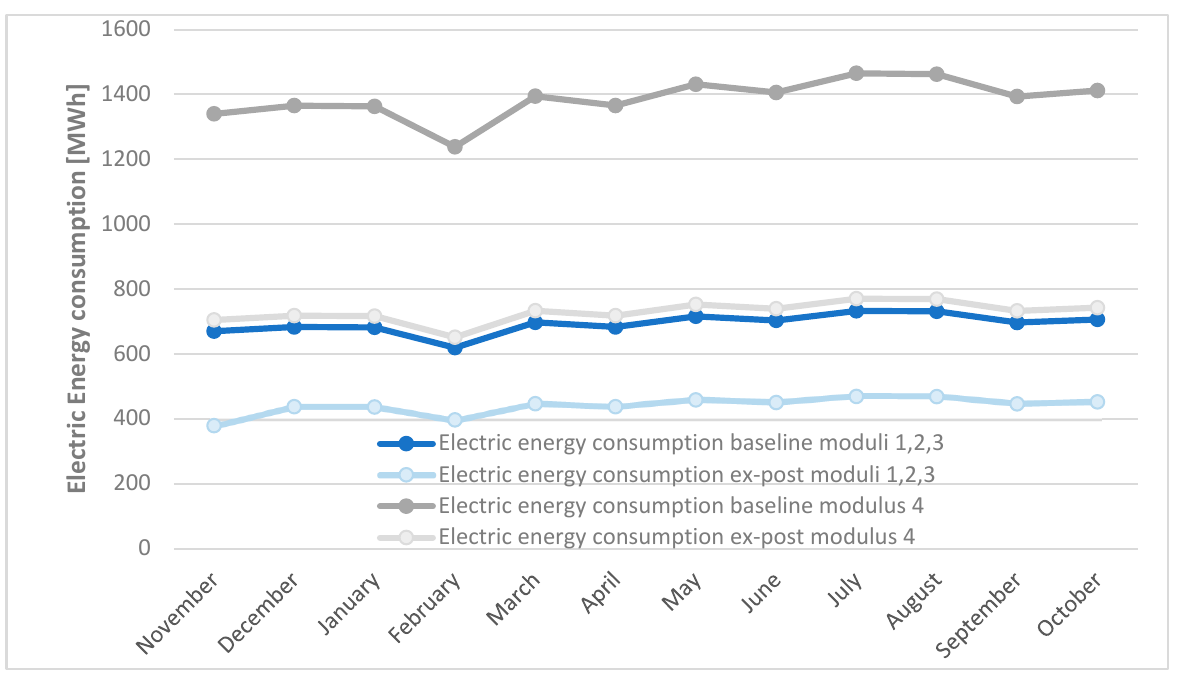
Figure 5. Electric energy consumption for moduli 1, 2, 3, and 4.